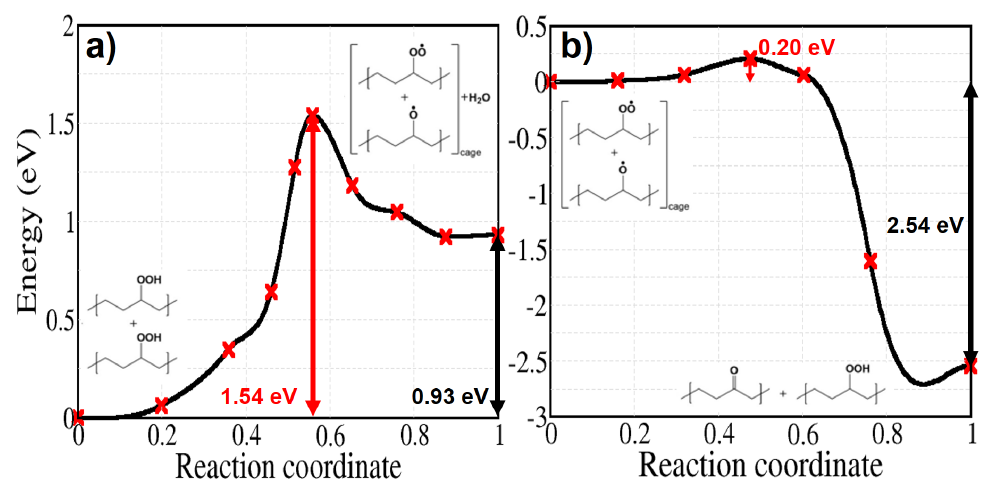
Figure 10. Energy profiles for reactions 7 ( a ) and 8 ( b ) of Figure 2 calculated for crystalline PE.